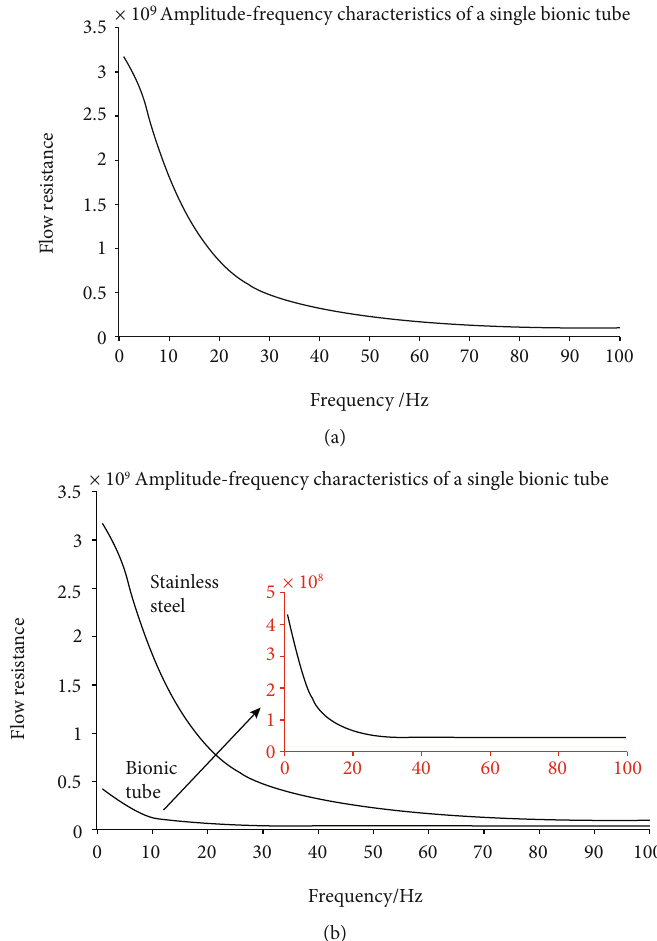
Figure 5: (a) Research on fl ow resistance characteristics of single steel pipe. (b) Research on fl ow resistance characteristics of single steel pipe and bionic